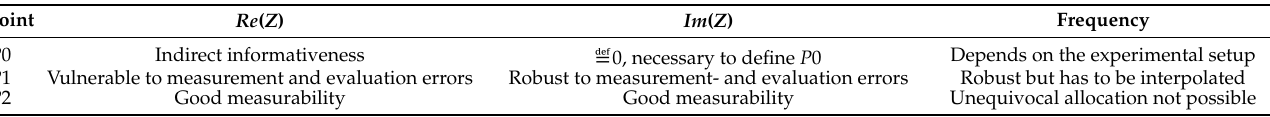
Table 2. Evaluability of the characteristic points in comparison.